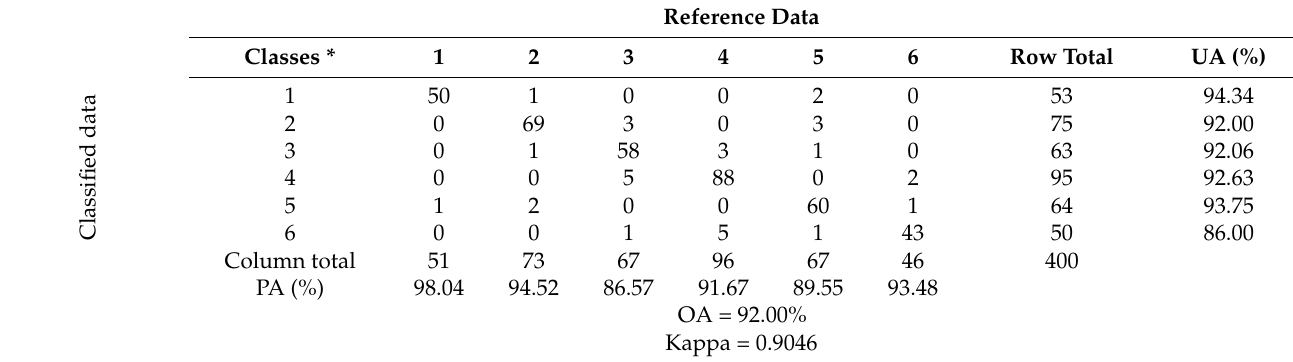
Table A4. Error matrix relating to accuracy assessment of the classified LULC map of 2006.